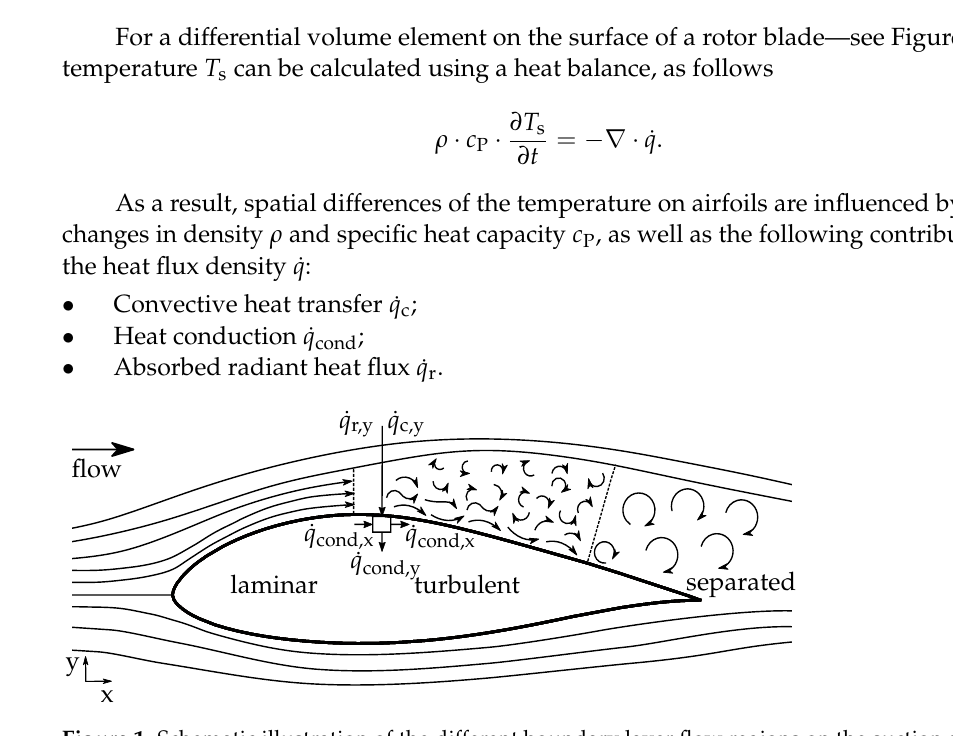
Figure 1. Schematic illustration of the different boundary layer flow regions on the suction side of an airfoil with trailing edge turbulent flow separation. A differential volume element with heat input and output normal to the surface by absorbed radiant heat flux ˙ q r, y , convective heat transfer ˙ q c, y and heat conduction ˙ q cond, y are also shown. In the direction of flow, the lateral heat conduction ˙ q cond, x